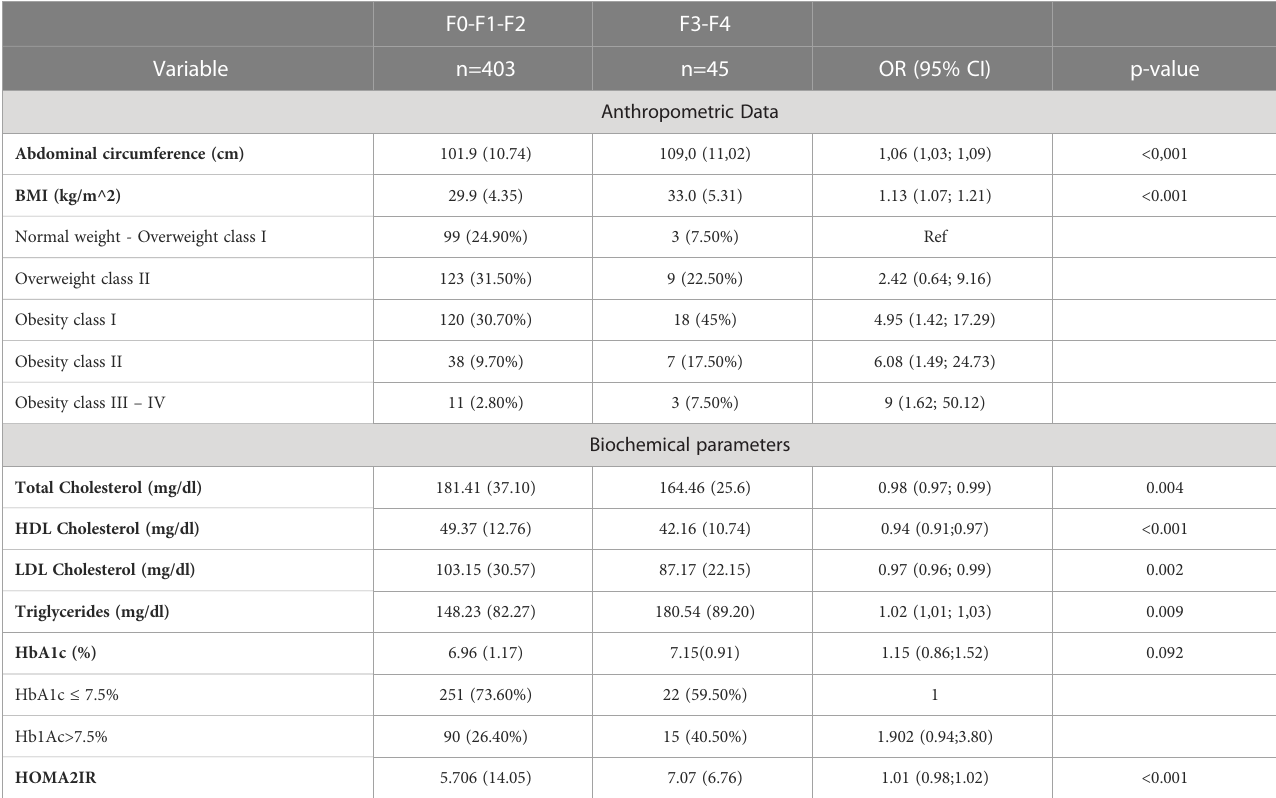
TABLE 3 Factors associated to hepatic fi brosis by